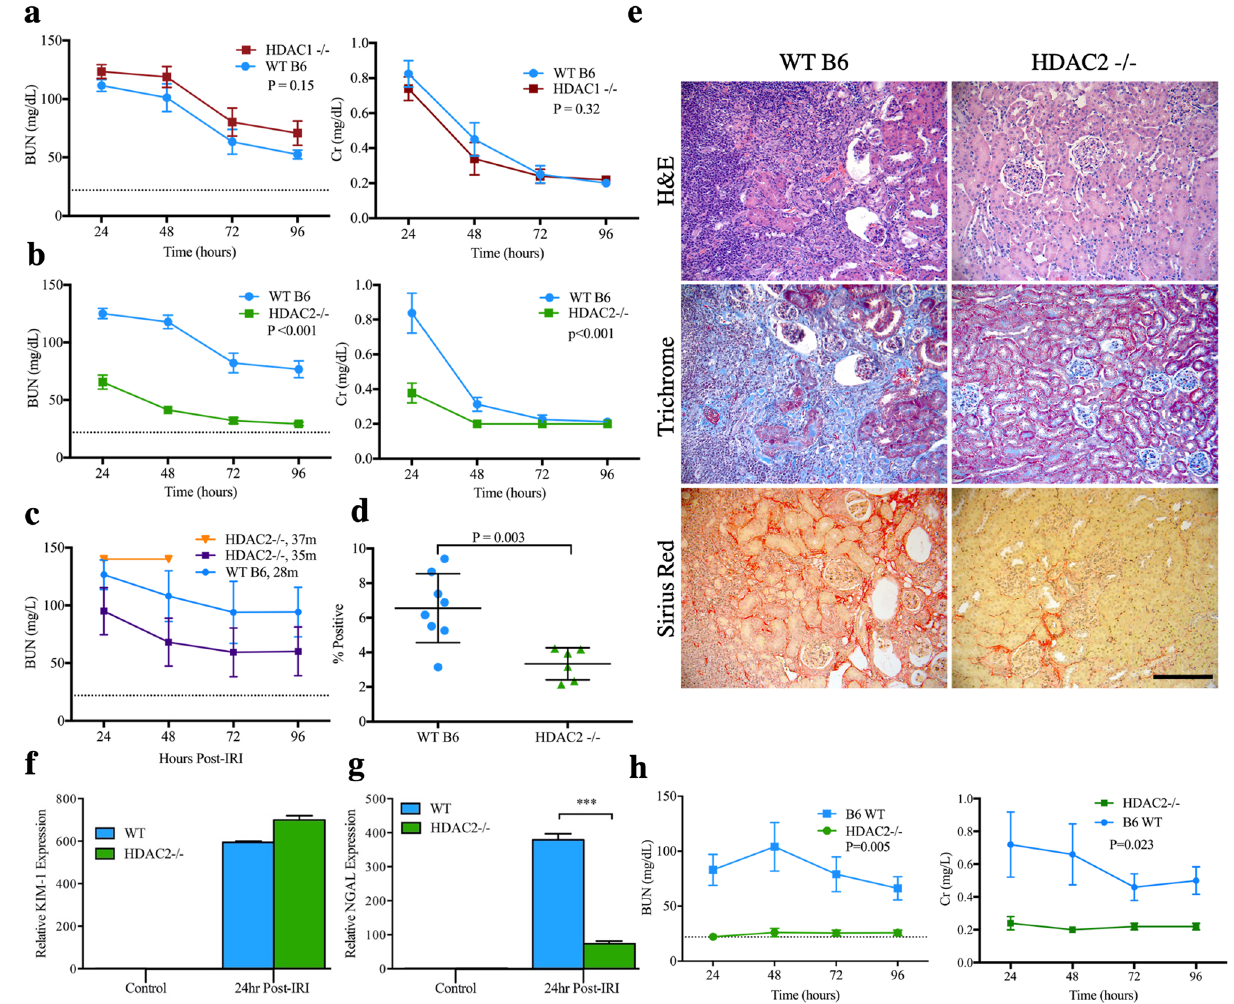
Figure 1. BUN and Cr after 28 min of warm IRI in WT female mice compared to ( a ) HDAC1-/- and ( b ) HDAC2-/- female mice. ( c ) BUN and Cr after extended IRI in HDAC2-/- female mice. HDAC2-/- mice exposed to 37 min of ischemia died from renal failure within 48 h of injury. Data are expressed as mean ± SEM (5 mice/ group), and significance was determined with 2-way analysis of variance (ANOVA). Dotted line at BUN = 22 (and in subsequent panels of BUN data) reflects baseline BUN of WT C57BL/6 mice. ( d ) Computerized scoring of renal fibrosis at 28 days (Sirius Red staining); data are expressed as mean ± SD, and significance was determined by unpaired t-test, n = 8 WT, n = 6 H2-/- mice. ( e ) Representative hematoxylin and eosin (H&E), trichrome, and Sirius Red staining of kidneys collected 28 days after warm IRI from WT and HDAC2-/- mice, scale marker = 50 µM. Relative expression of ( f ) KIM-1 and ( g ) NGAL at baseline and 24 h following 28 min of warm IRI in WT B6 and HDAC2-/- kidneys; data are expressed as mean ± SD, and significance was determined by 2-way ANOVA, n = 3. ( h ) BUN and Cr following 15 min of warm IRI in HDAC2-/- and WT male mice; data are expressed as mean ± SEM (5 mice/group), and significance was determined by 2-way